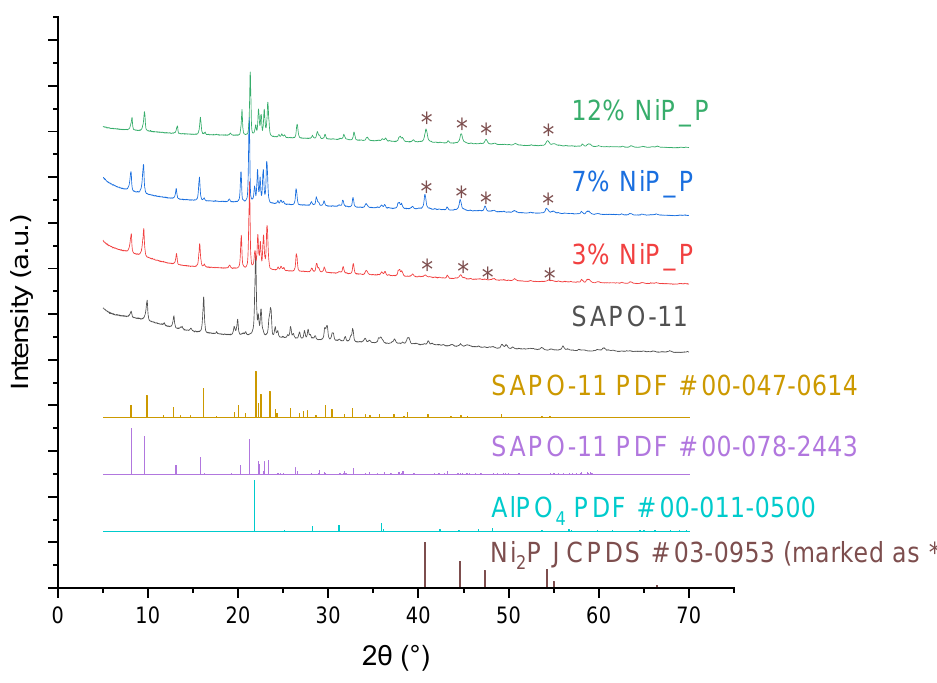
Figure 10. XRD patterns of the NiP_P samples and the SAPO-11 support. The initial SAPO-11 support consisted of agglomerates of elongated particles with sizes of ~1 μm (Figure S6). TEM images of the NiP_P catalysts show that the SAPO-11 particles are evenly covered with Ni 2 P nanoparticles (Figure 11).